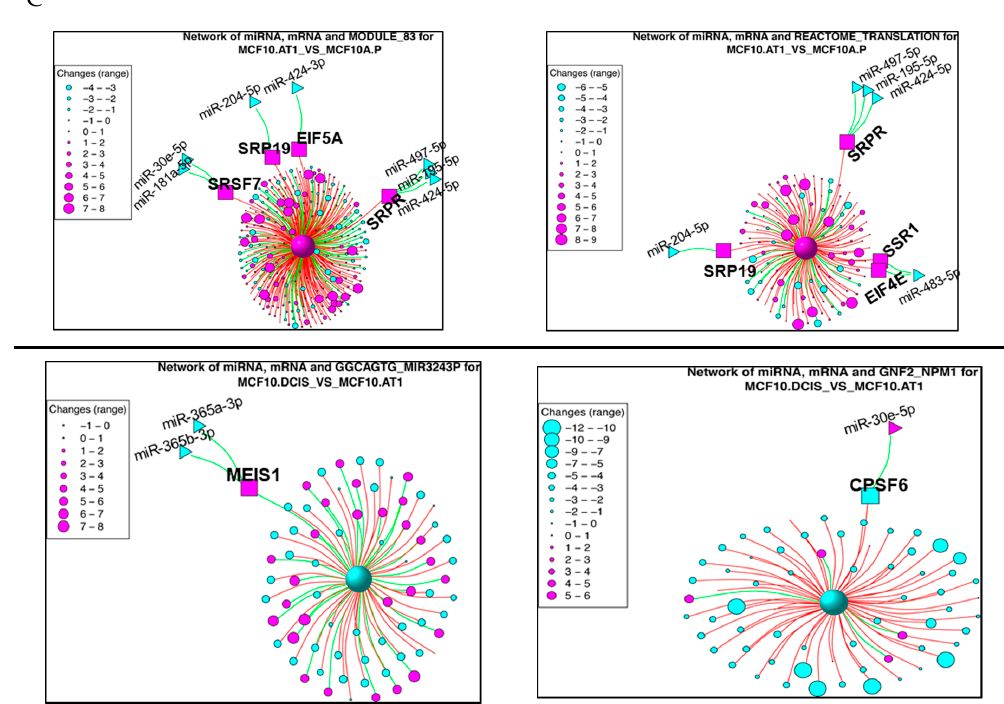
Figure 8. miRNAs and their target genes and target pathways that changed across histological progression. ( A and B ) Heat maps showing the miRNAs and their target genes and pathways that mapped to ( A ) Group 2 or ( B ) Group 7 and represent early changes across the preneoplastic transition of breast cancer progression. The color key shows blue as the lowest expression and red as the highest expression. ( C ) Network diagrams for the top two pathways derived from the transitions of normal MCF10A.P to preneoplastic MCF10.AT1 cells and MCF10.AT1 to MCF10.DCIS cells. The large central sphere represents the core pathway, with more peripheral circles representing genes that regulate the pathway. The sizes of these peripheral circles are scaled to show their relative impact on the pathway. Selected miRNAs are shown in triangles, with their gene targets represented within squares. Magenta nodes represent activation of the pathway/gene/miRNA, while blue nodes represent suppressed pathways/genes/miRNAs. Green lines between green nodes represent upregulation; green lines between a green and red node represent repression. Similarly, red lines between red nodes represent upregulation, and red lines between a green and red node represent inhibition.